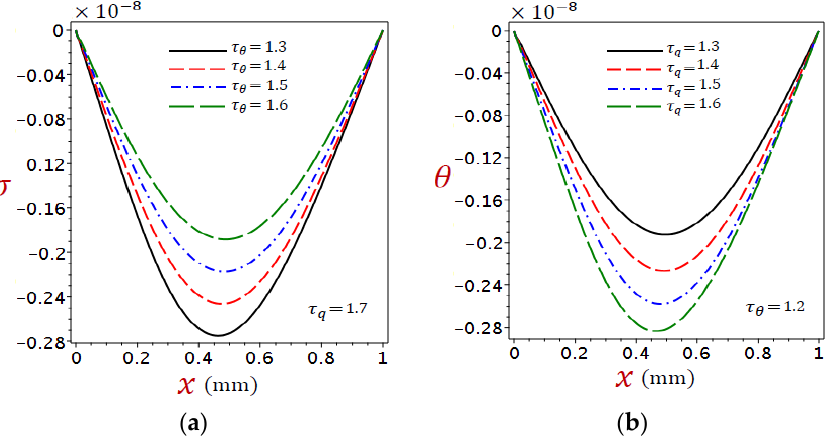
Figure 12. Distributions of stress ( σ ) for refined DPL model under ( a ) different τ θ with τ q = 1.7 and ( b ) different τ q with τ θ = 1.2.